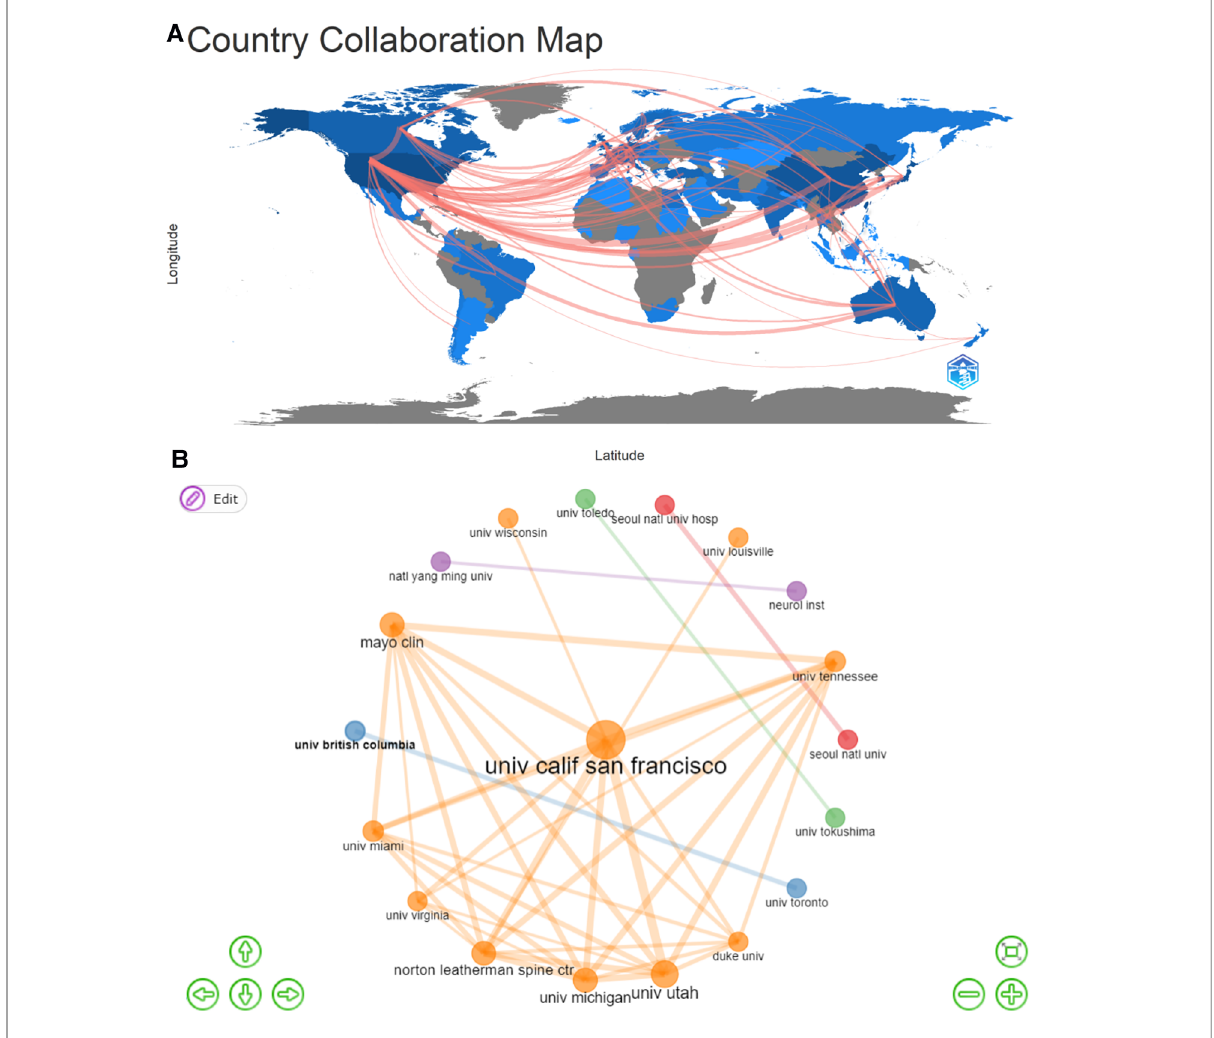
FIGURE 2 Collaborations in lumbar spondylolisthesis fi eld. ( A ) collaborations among countries/regions; ( B ) collaborations among